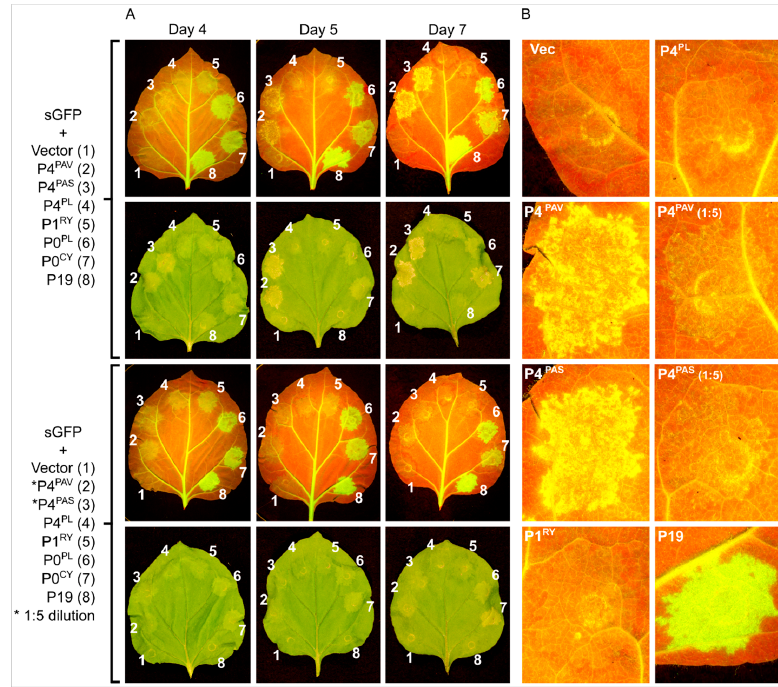
Figure 4. Induction of necrosis by different luteovirus P4 proteins is dose-dependent. Agro-infiltration of GFP-expressing N. benthamiana 16c leaves with sense GFP transgene (sGFP) plus the BYDV-PAV